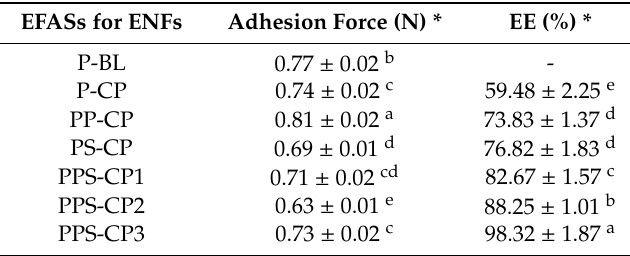
Table 3. Adhesion force and entrapment e ffi ciency (EE) values of ENFs obtained from various